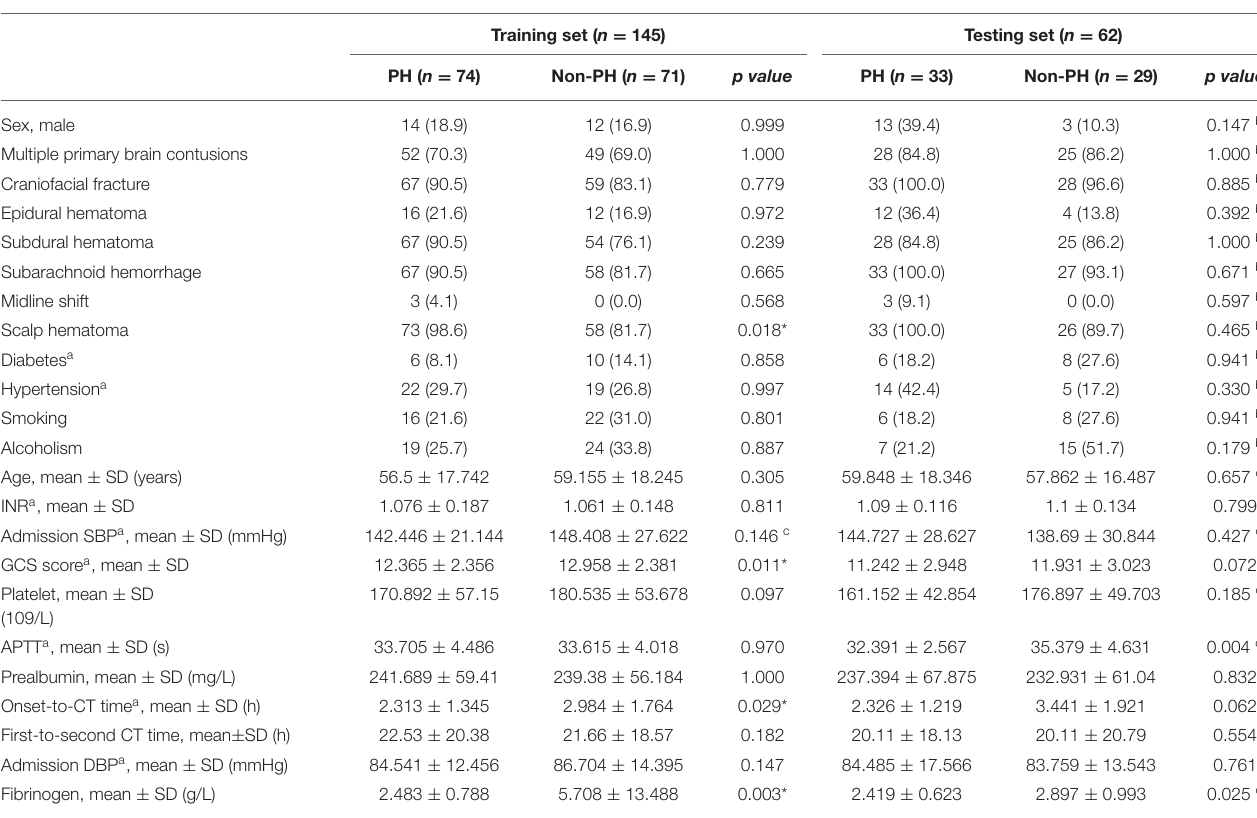
TABLE 1 | Comparisons of patient characteristics in the training set and testing set. Training set ( n = 145) Testing set ( n =